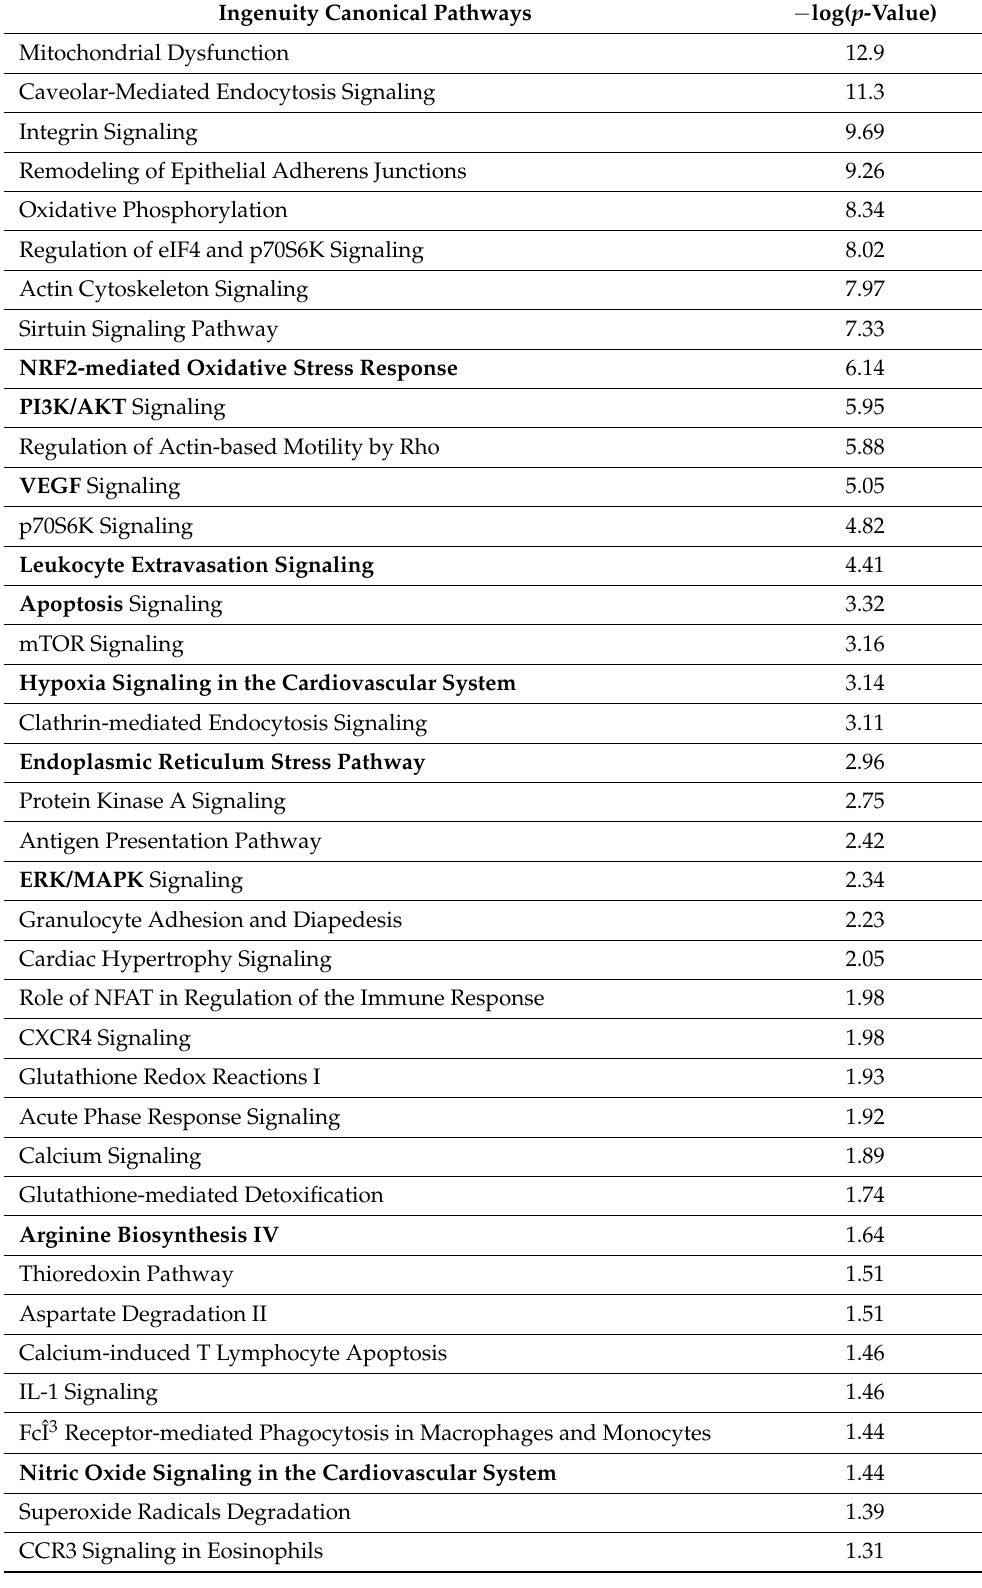
Table 1. List of enriched pathways in which proteins carried by eEV and eEV-IL-3 are involved. Ingenuity Canonical